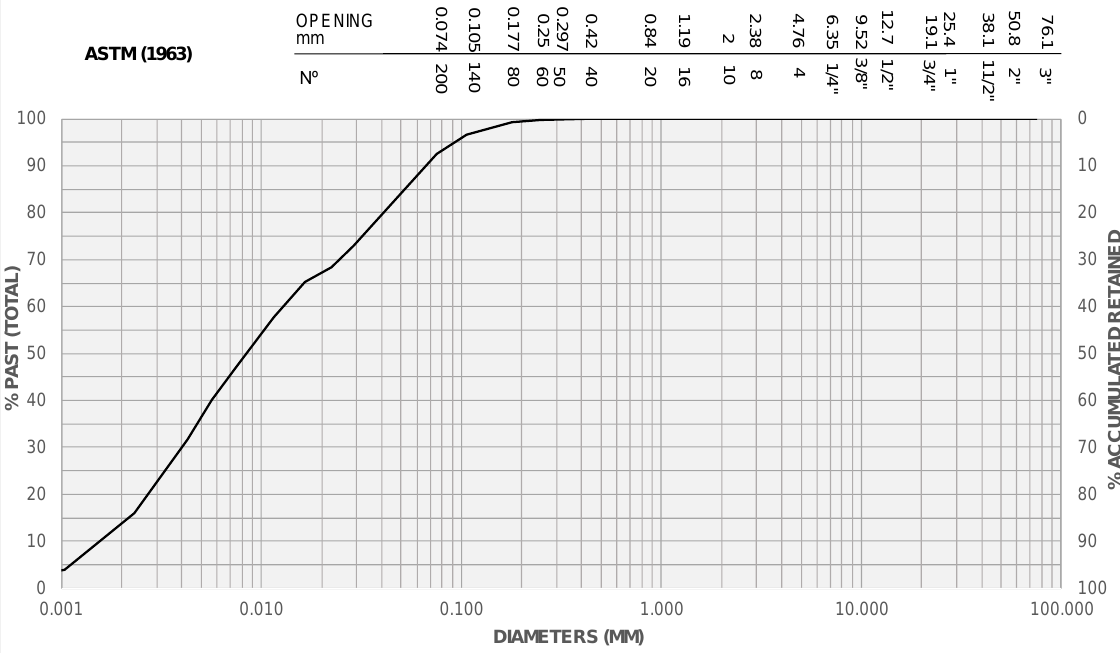
Figure 2. Grading curve of the mine tailing.